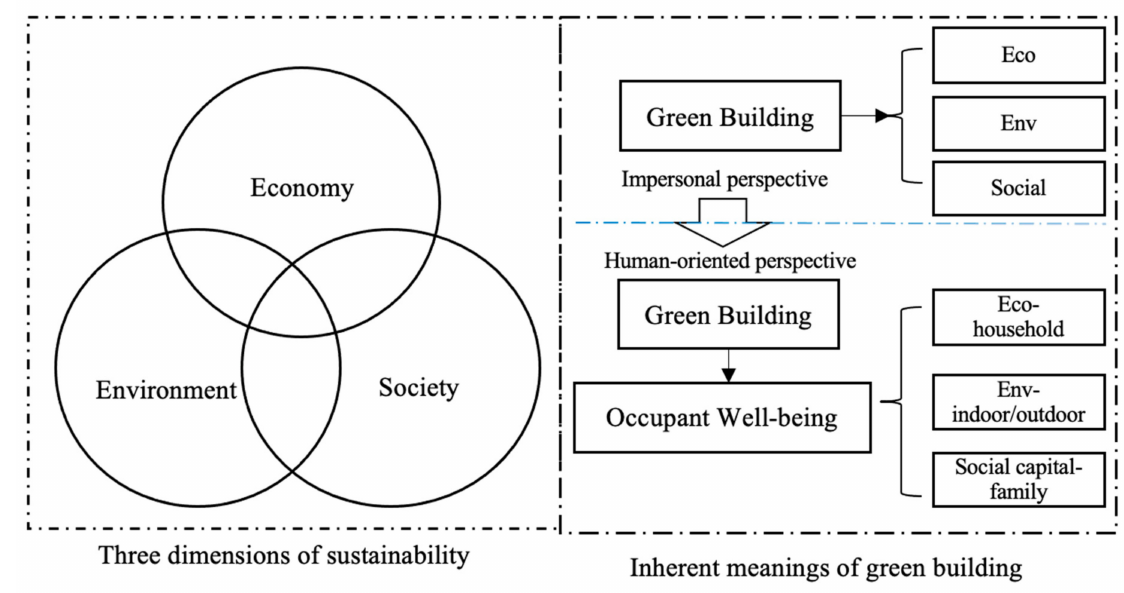
Figure 1. Inherent meanings shift from “Turning green into gold” to “Enabling green for